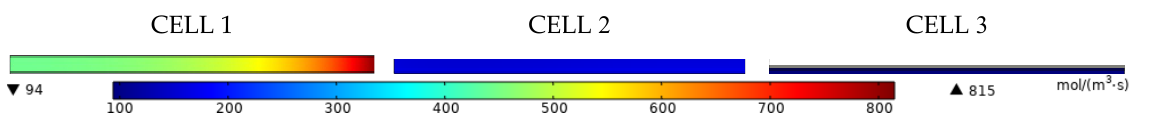
Figure 4. Reaction rate distribution of steam reforming along catalyst layers from top to bottom in mol/(m 3 · s).